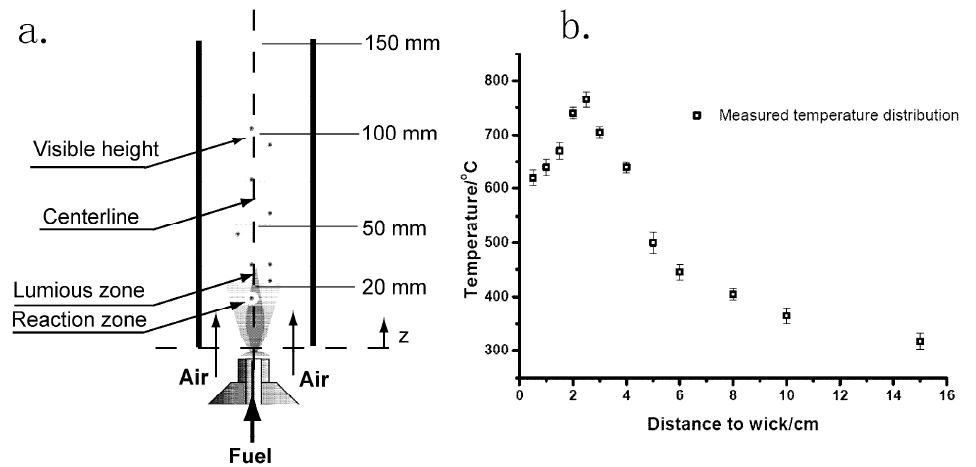
Figure 12. ( a ) Sketch of non-premixed burner showing sampling position on the flame axis; ( b ) The measured temperature profile over flame axis.